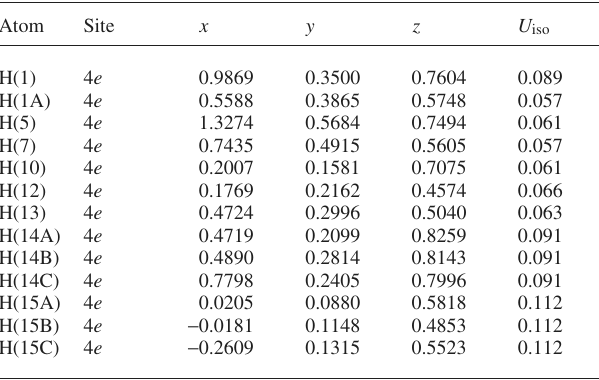
Table 2. Atomic coordinates and displacement parameters (in Å 2 )